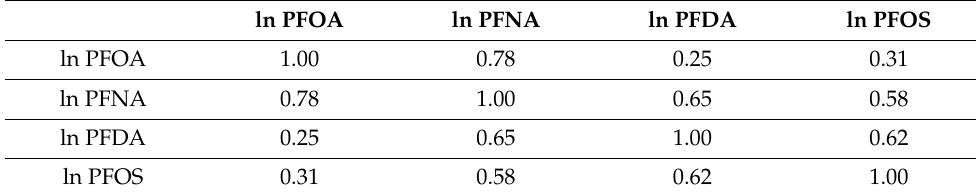
Table 4. Concurvity indexes between PFAS variables.